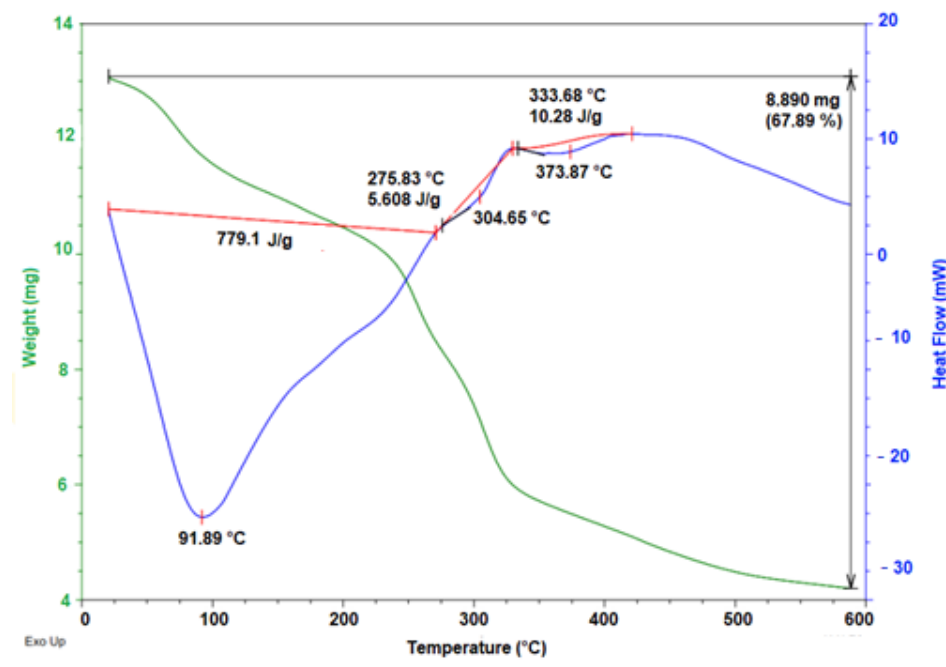
Figure 6. TGA/DSC thermogram of powder mucilage from yellow pitahaya fruit peel.